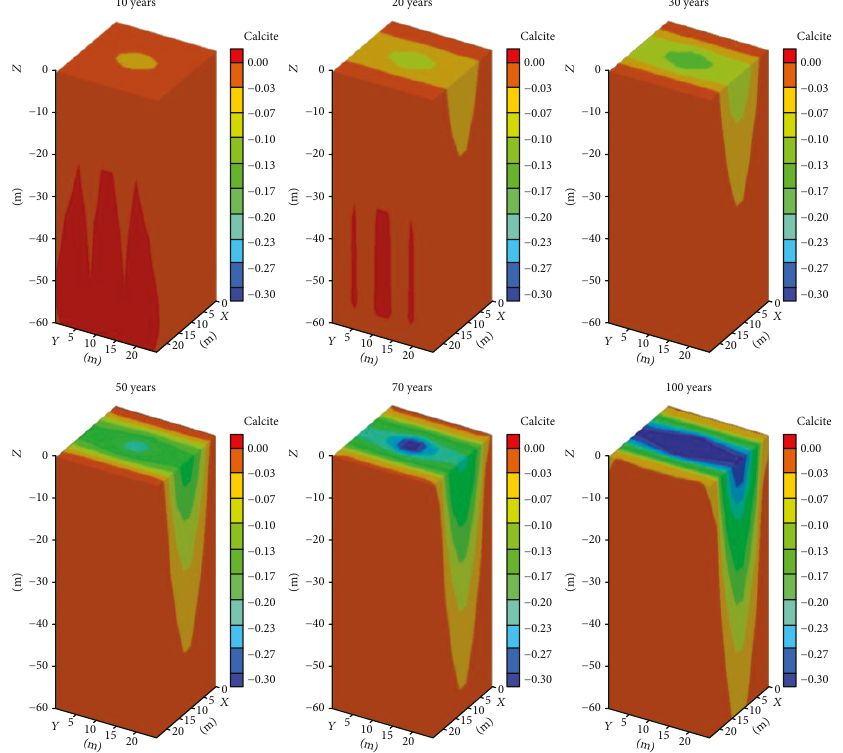
Figure 15: The corrosion range of the fi ssure under strong hydrodynamic conditions-medium permeability — 20 ° C.